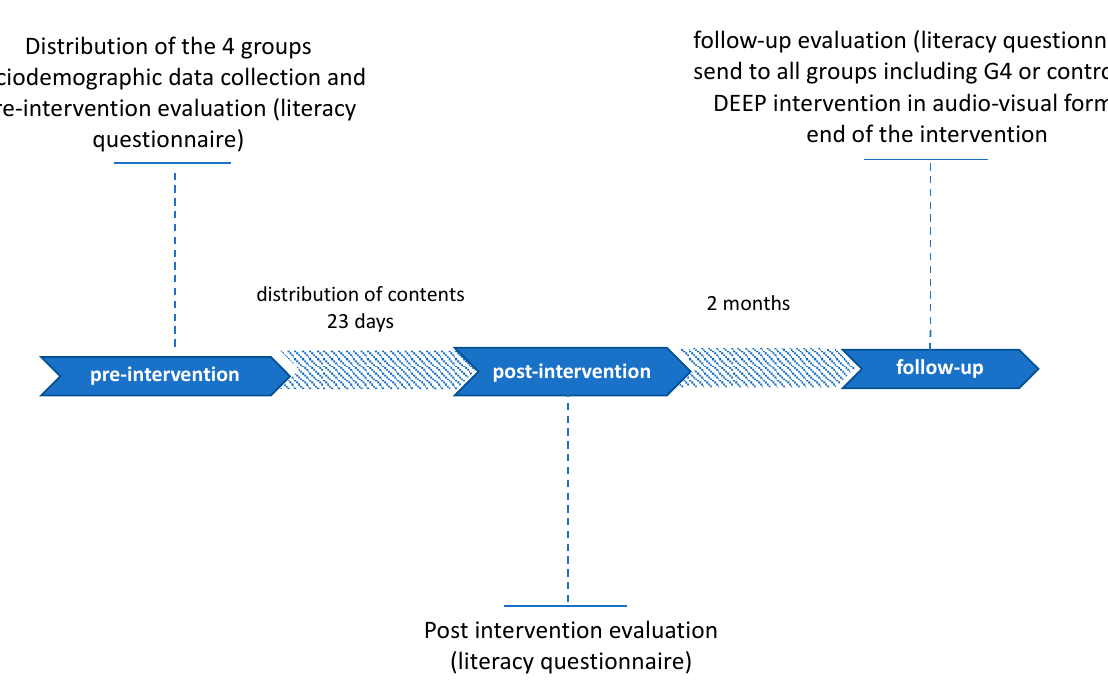
Figure 1. Timeline of the assessment design.